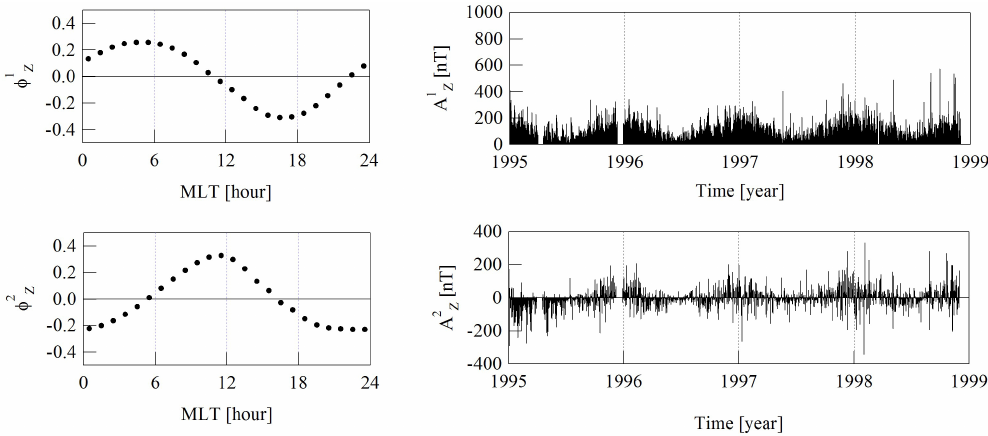
Fig. 4. On the left, the first (top) and the second (bottom) EOF associated to the Z component. On the right, the PCs associated to each